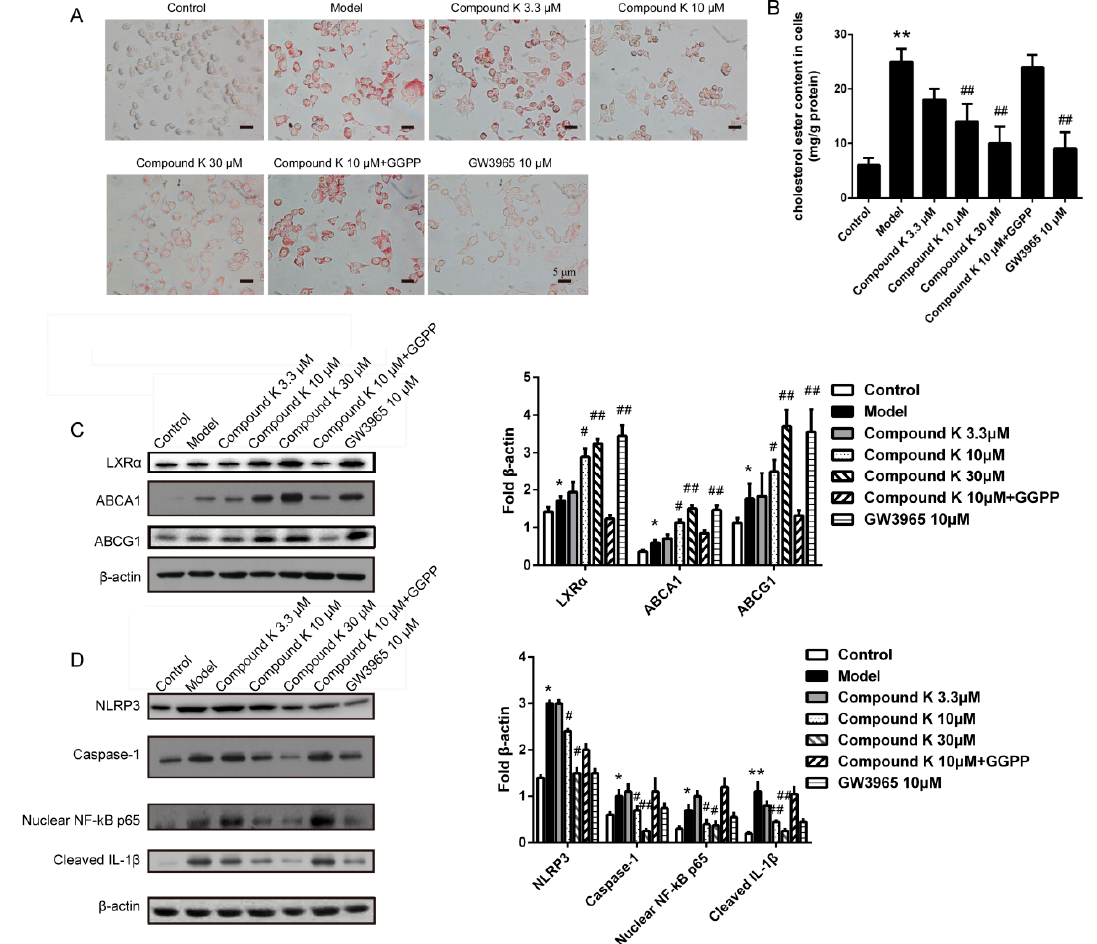
Figure 5. Effects of compound K on formation of foam cells and activity of inflammasome. Foam cells derived from macrophages treated by different concentration compound K were stained by Oil-red O. The visible positive stained lipid drops were detected under microscope ( A ); Concentrations of cholesteryl ester in foam cells were detected ( B ); Levels of LXR α , ABCA1 and ABCG1 in foam cells were detected by immunoblotting and normalized to β -actin ( C ); The level of cleaved-IL-1 β in cholesterol crystal (1 mg/mL) stimulated macrophages was detected by immunoblotting ( D ); To investigate the probably mechanism, the levels of NLRP3, caspase-1 and nuclear NF- κ B p65 were detected by western blot, and normalized to β -actin ( D ). Data are presented as mean ± SEM ( n = 6). * p < 0.05 vs. control; * p < 0.01 vs. control; # p < 0.05 vs. model; ## p < 0.01 vs. model.